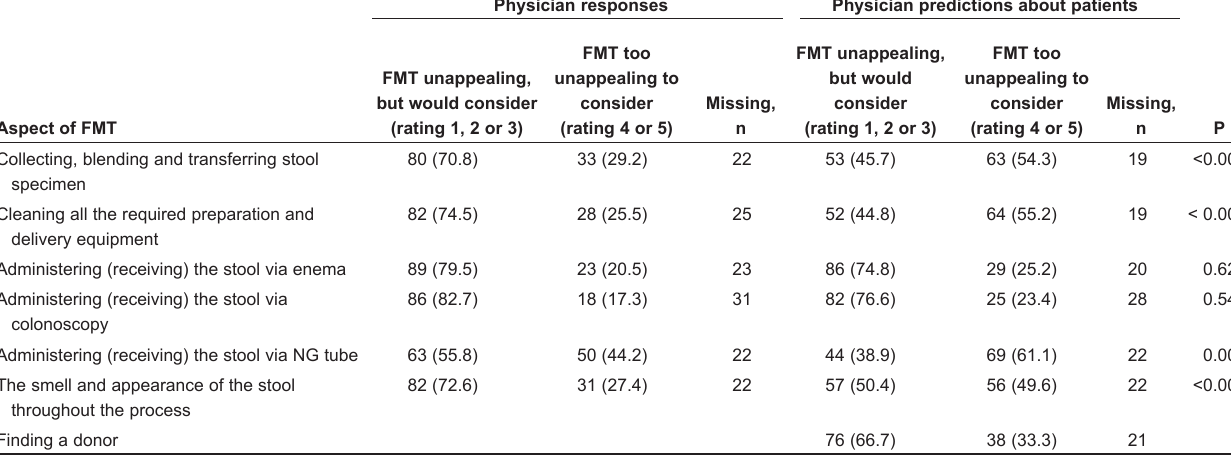
TAble 5 likert rating scale* of physician responses to questions regarding their own views about aspects of fecal microbiota transplatation (FMT) and their predictions about how patients would answer the same